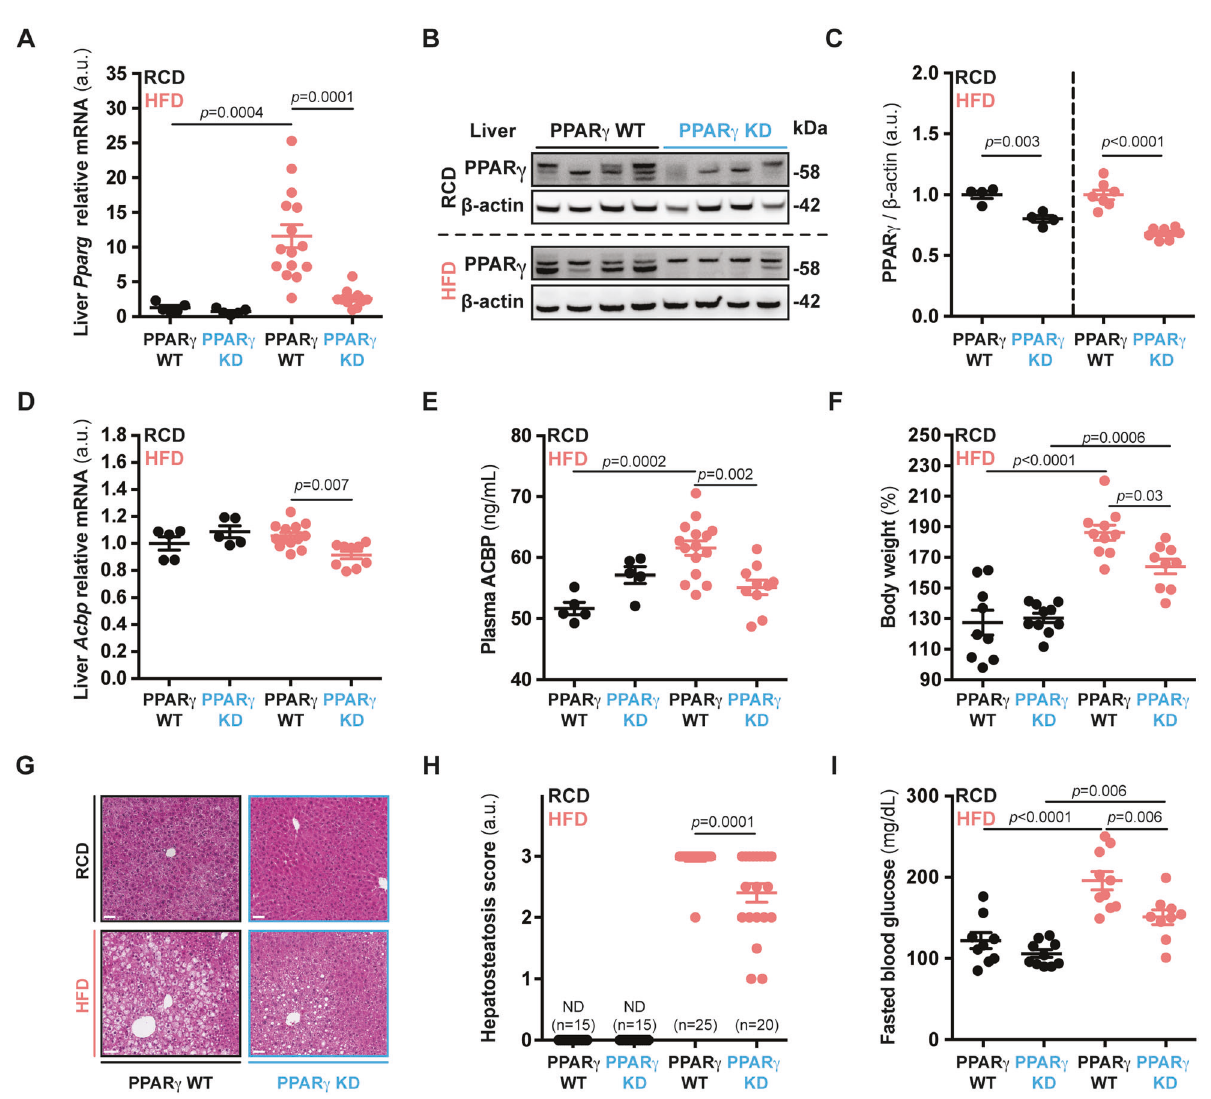
Fig. 4 Liver-speci fi c PPAR γ knockout yields decreased ACBP levels. A Pparg mRNA expression ( n = 5 to 15 mice per condition) and B , C protein level measurements ( n = 4 to 7 mice per condition) in liver extracts obtained from control (PPAR γ WT) or liver-speci fi c CRISPR/ Cas9-mediated PPAR γ -knockdown mice (PPAR γ KD) receiving regular-chow (RCD) or high-fat diet (HFD). For statistical analysis ( C ) p values were calculated comparing HFD groups to the corresponding RCD group for each genetic background (PPAR γ WT, PPAR γ KD). D Acbp mRNA expression ( n = 5 to 13 mice per condition), E plasma ACBP concentration ( n = 5 to 15 mice per condition), and F body weight gain measurements in control or PPAR γ KD mice rendered obese (HFD, 2 months) ( n = 9 to 10 mice per condition). G Representative hematoxylin eosin (HE) images of control or PPAR γ KD livers ( n = 15 to 25 mice per condition) obtained from mice receiving RCD or HFD, hepatosteatosis score quanti fi cation (bar: 50 μ m, ND non-detected) ( H ). I Fasted blood glucose concentration from control or liver-PPAR γ KD mice receiving RCD or HFD ( n = 9 to 10 mice per condition). Results are displayed as whisker plots (with each dot representing one single mouse) including the mean ± SEM. For statistical analysis p values were calculated by two-tailed unpaired Student ’ s t -test ( C ), two-way ANOVA ( A , D – F , I ), or Mann – Whitney test ( H ). kDa kilodaltons, a.u. arbitrary units, ns non-signi fi cant, ND non-detected. See also Fig.